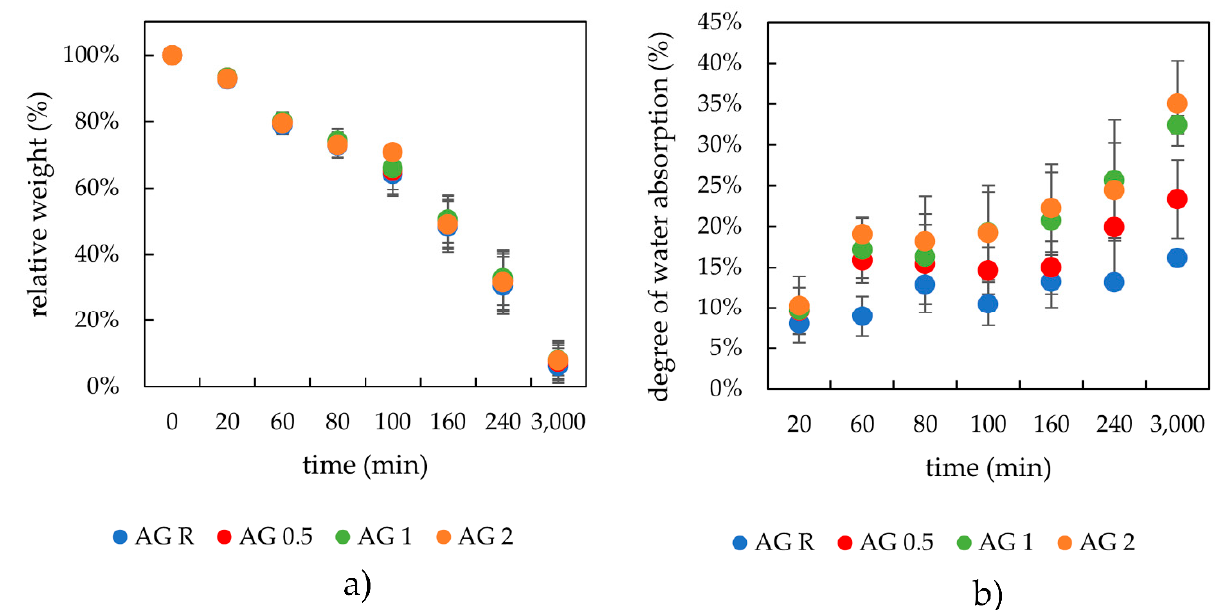
Figure 2. Drying ( a ) and rehydration ( b ) of the physically crosslinked agarose hydrogels with different contents of lecithin.